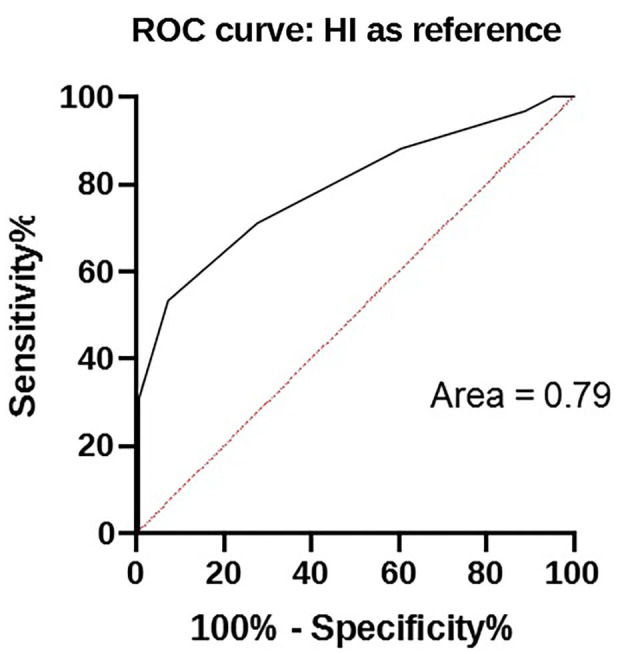
ROC curve between in-clinic ELISA test and HI titers of samples.